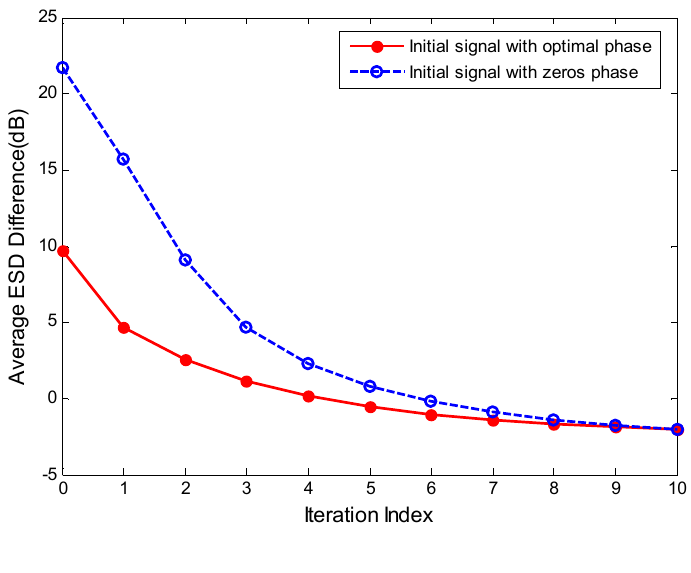
Figure 7. Average ESD difference and SCNR